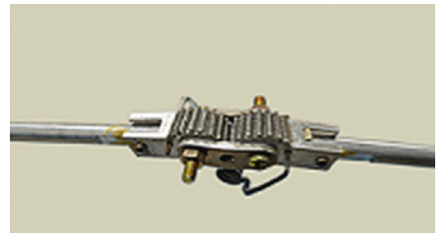
Figure 7: Physical model of the deployable joint.